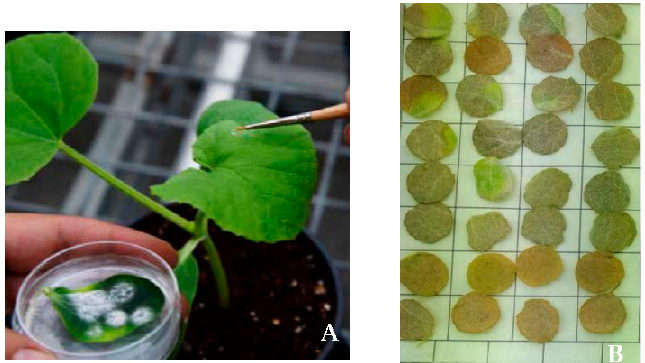
Figure 1. ( A ) Plants inoculated artificially by depositing a small amount of conidia at two spots on the second true leaf of melon plants. ( B ) Leaf disk inoculation method.